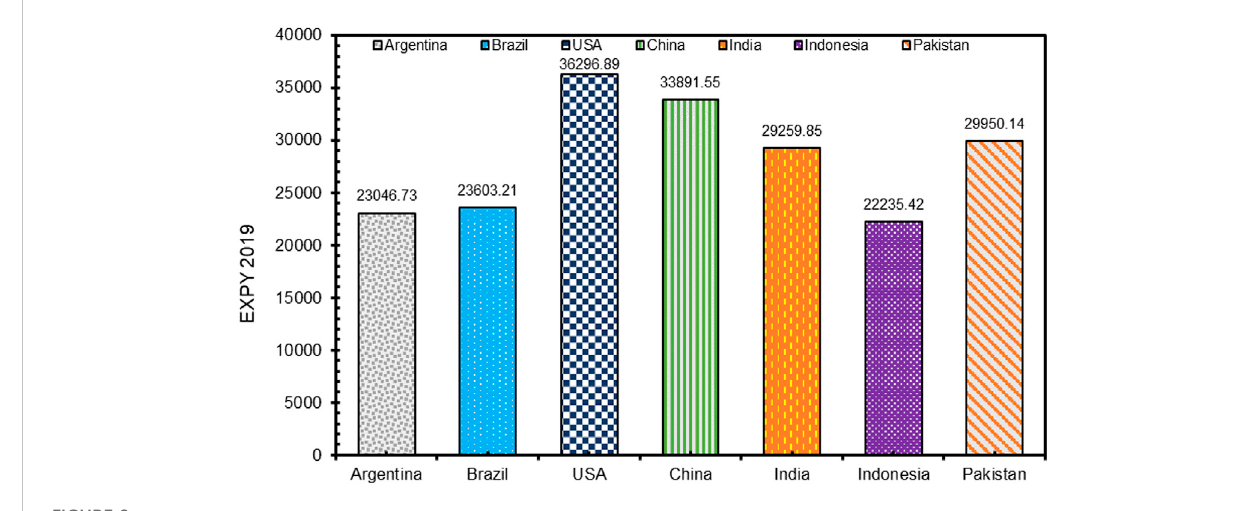
FIGURE 2 EXPY of all the investigated countries in 2019.